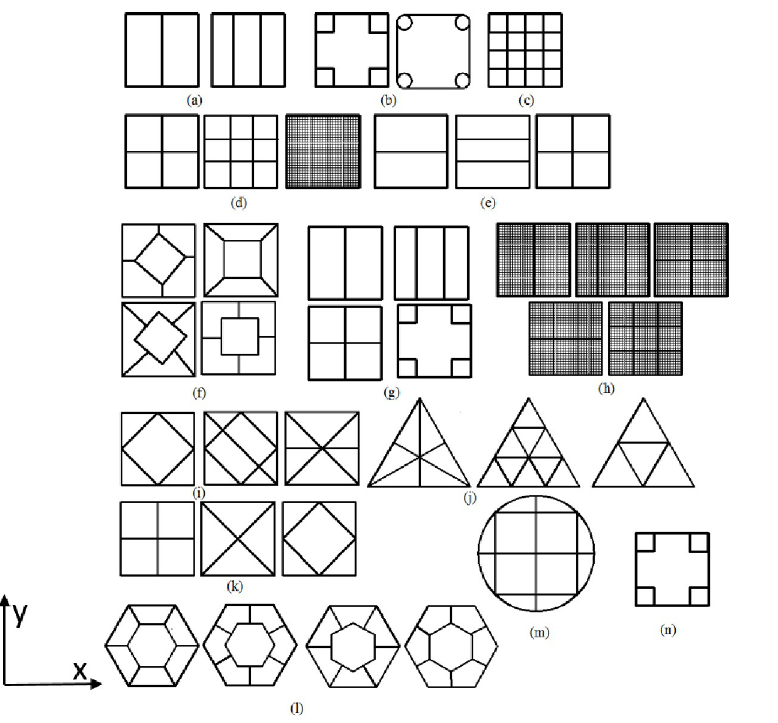
Fig 1. Cross-sectional shape of the multi-cell